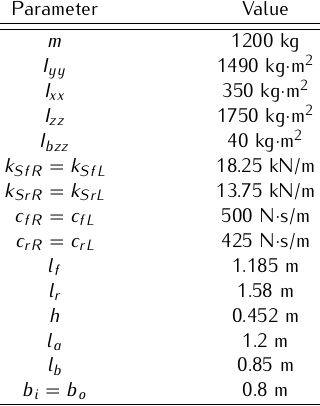
Table 1. The values of the different pa- rameters which are used in the